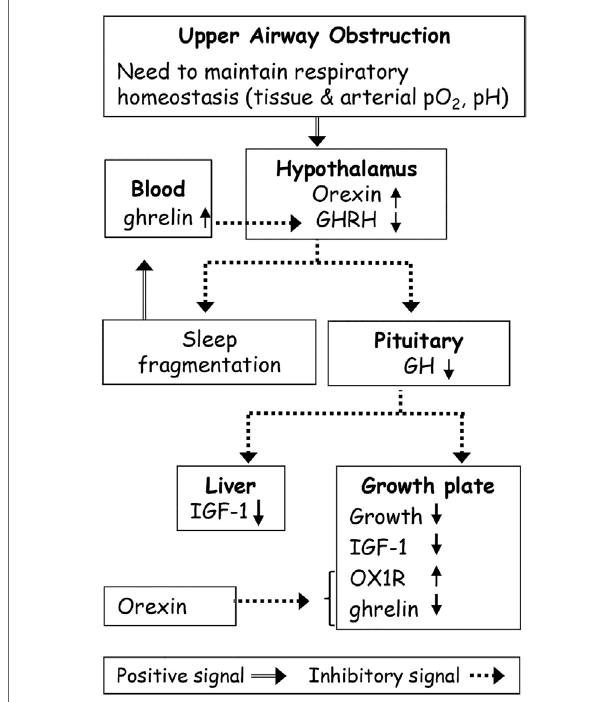
FiGURe 1 | Possible effects of upper airway obstruction (AO) on sleep and growth. Upper AO leads to adaptive changes in the respiratory mechanics to maintain respiratory homeostasis. Orexin plays a role in maintaining breathing homeostasis in AO via its primary role in carbon dioxide chemoreception. Orexin inhibits growth hormone (GH) release from the pituitary gland through inhibition of hypothalamic hormone-releasing hormone (GHRH) neurons. Abnormalities in GHRH underlie both growth and sleep disorders in AO. The continuous ghrelin elevation in AO possibly due to partial sleep loss and increased orexin was sufficient to desensitize the hypothalamic–pituitary–GH axis. AO causes suppression of the GH axis, and of the global and local growth plate IGF-1 levels leading to growth retardation. Orexin receptor 1 (OX1R) plays a role in growth retardation by modulation of local ghrelin